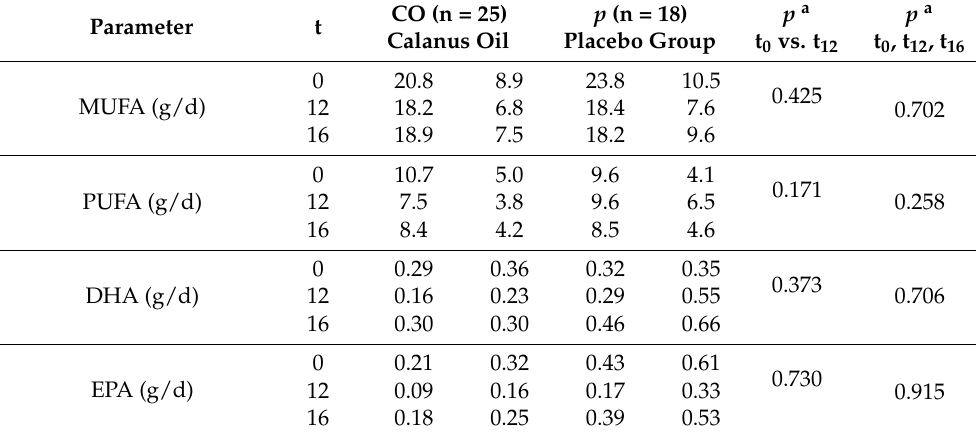
Table A2. Cont. Parameter